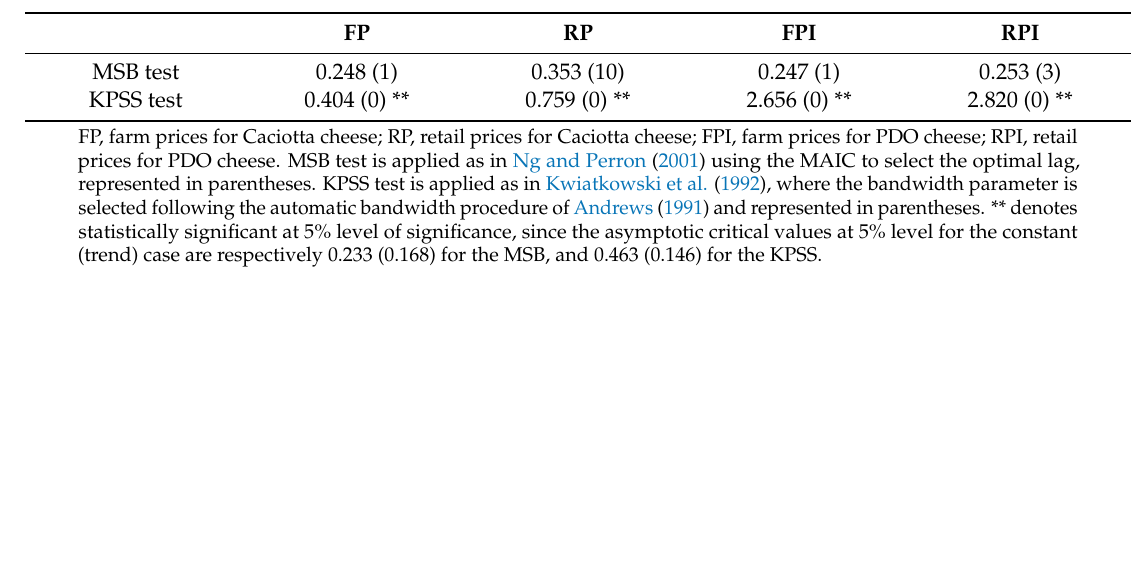
Table 2. Unit root and stationary